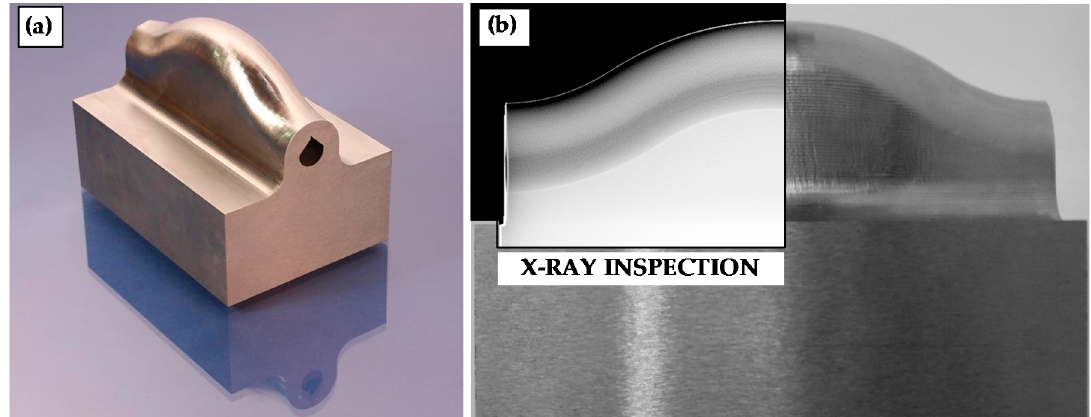
Figure 17. ( a ) Final part; ( b ) X-ray inspection.